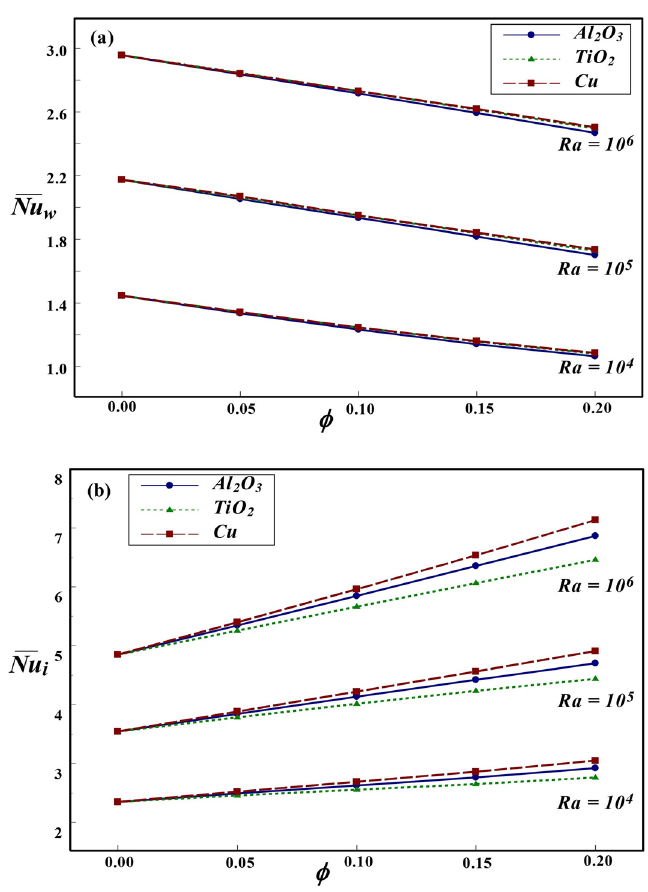
Figure 10. Effect of Ra and φ on Nu at the ( a ) wall and ( b ) interface for Kr = 2 and ε = 0.2